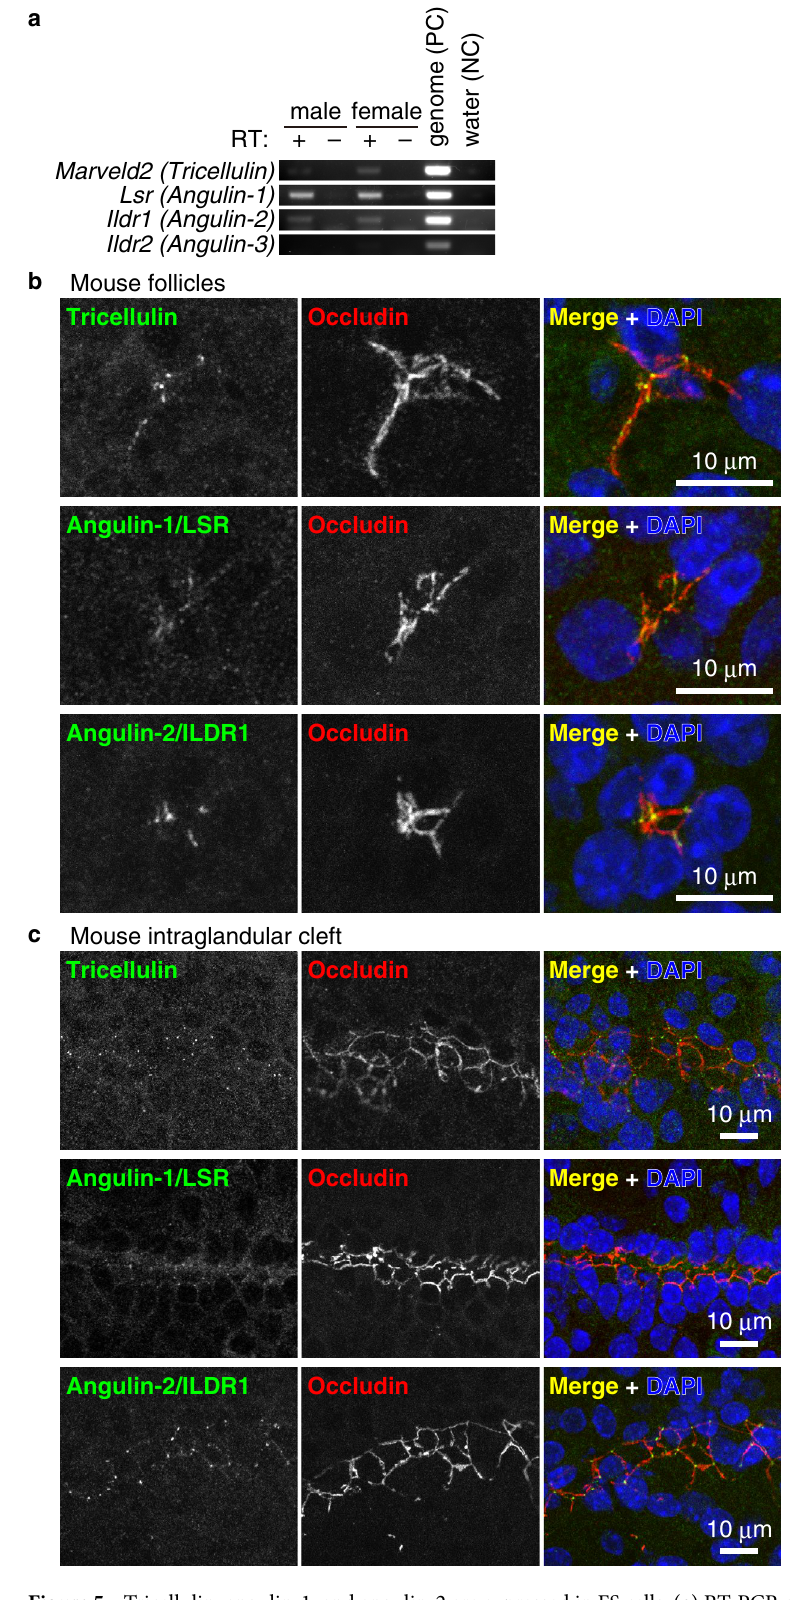
Figure 5. Tricellulin, angulin-1, and angulin-2 are expressed in FS cells. ( a ) RT-PCR of the pituitary gland of adult male and female mice. ( b ), ( c ) Immunostaining of the adult mouse anterior pituitary gland using anti- tricellulin mAb (green) and anti-occludin pAb (red), anti-angulin-1 pAb (green) and anti-occludin mAb (red), and anti-angulin-2 pAb (green) and anti-occludin mAb (red) together with DAPI